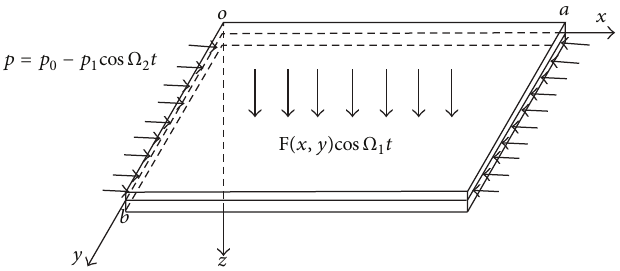
Figure 1: The model of a rectangular FGM plate and the coordinate